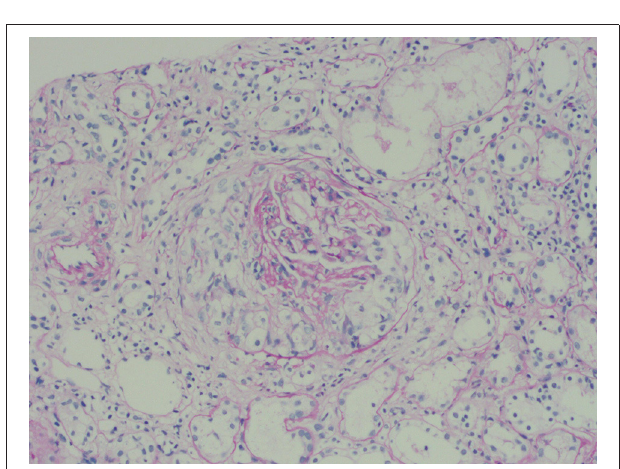
FIGURE 2 | Light microscopy revealed 44 cellular crescents in 72 glomeruli.